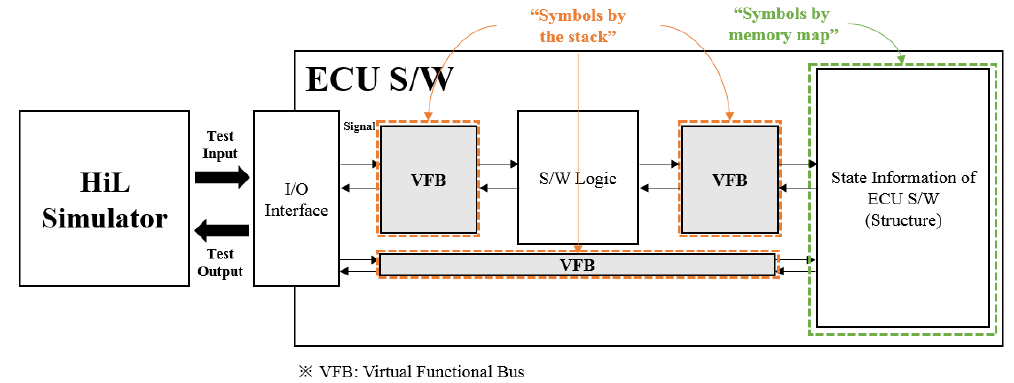
Figure 15. Differences of symbol types in fault candidates (memory map and stack). Table 5. Comparative results of the two fault ‐ localization methods.